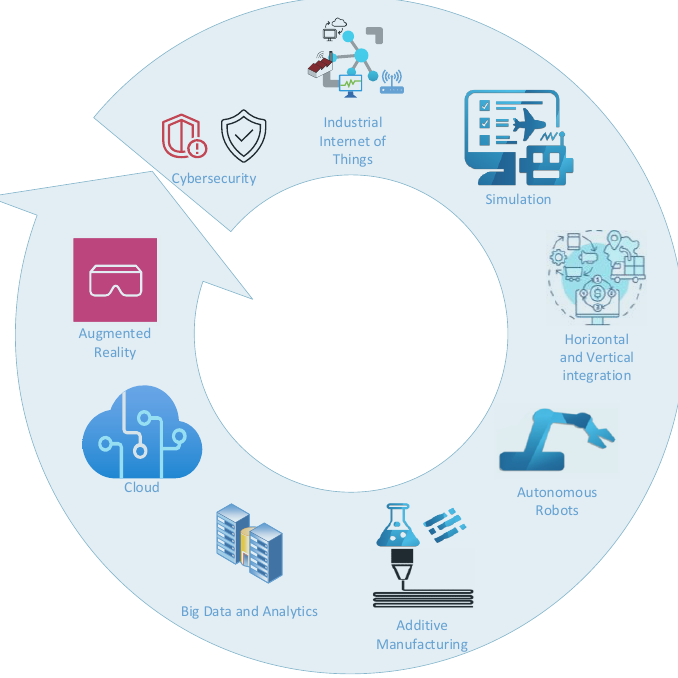
Figure 6. Industry 4.0-Enabling Technologies.